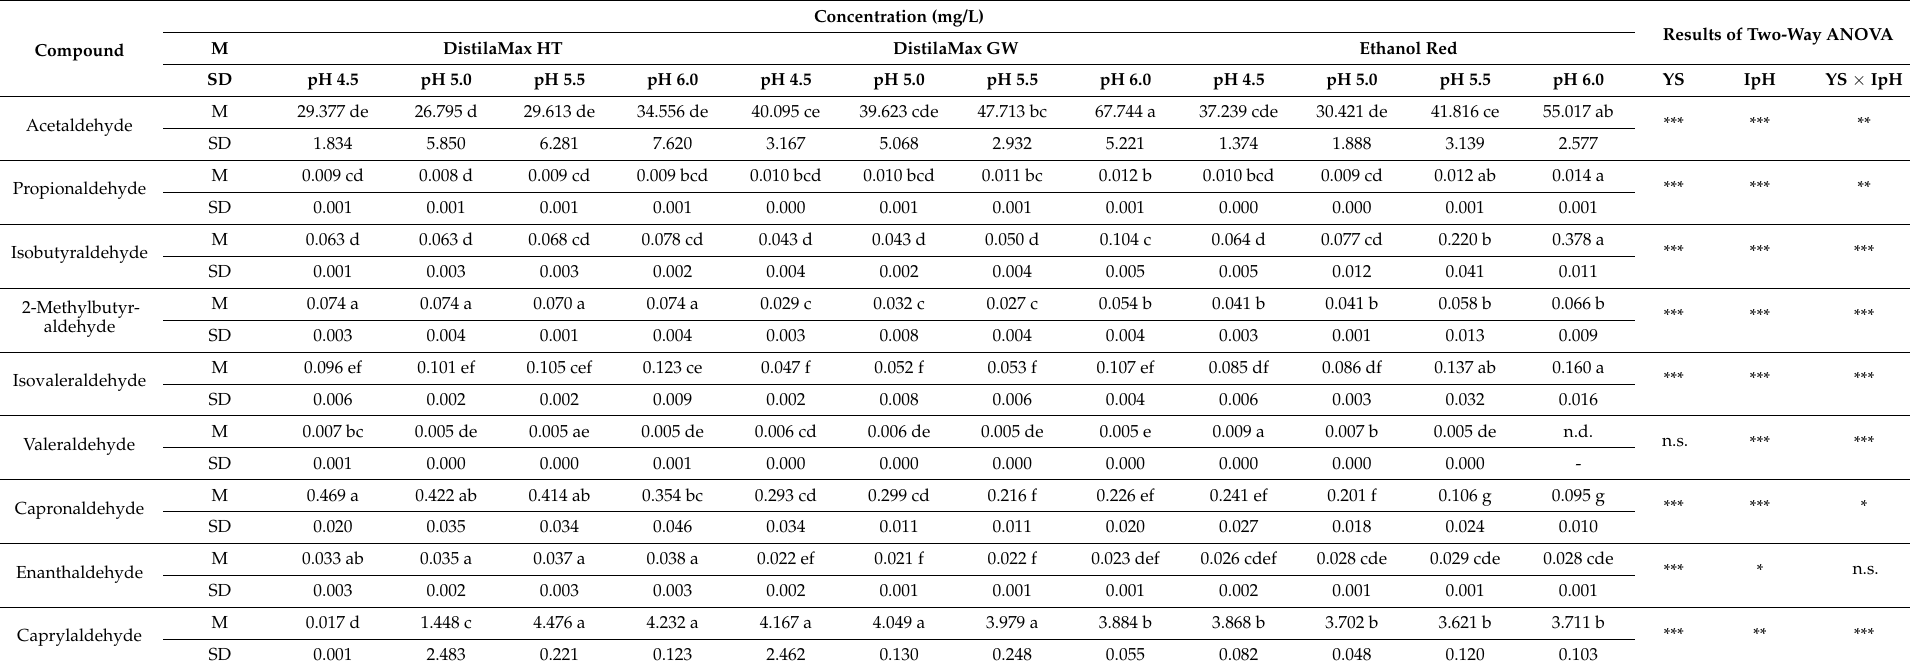
Table 7. Concentrations of aldehydes in the fermented mashes prepared using the PLS